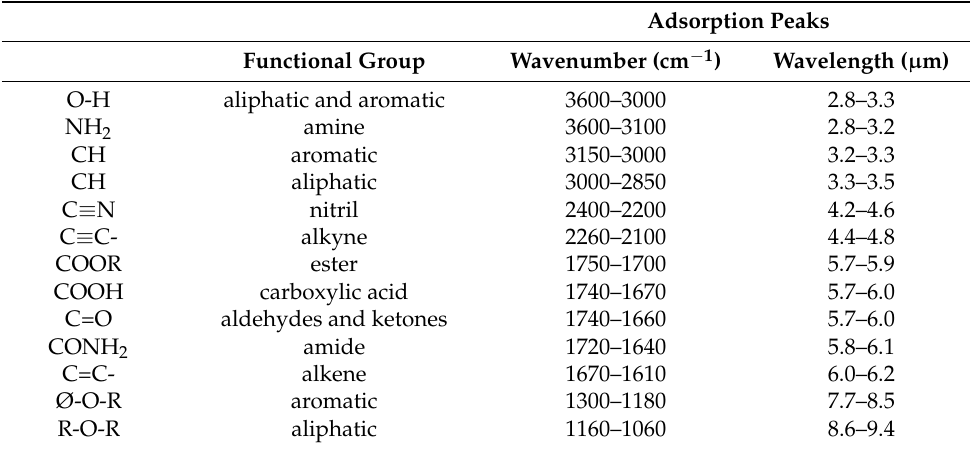
Table 3. Adsorption peaks of the functional groups. Adapted from [195].